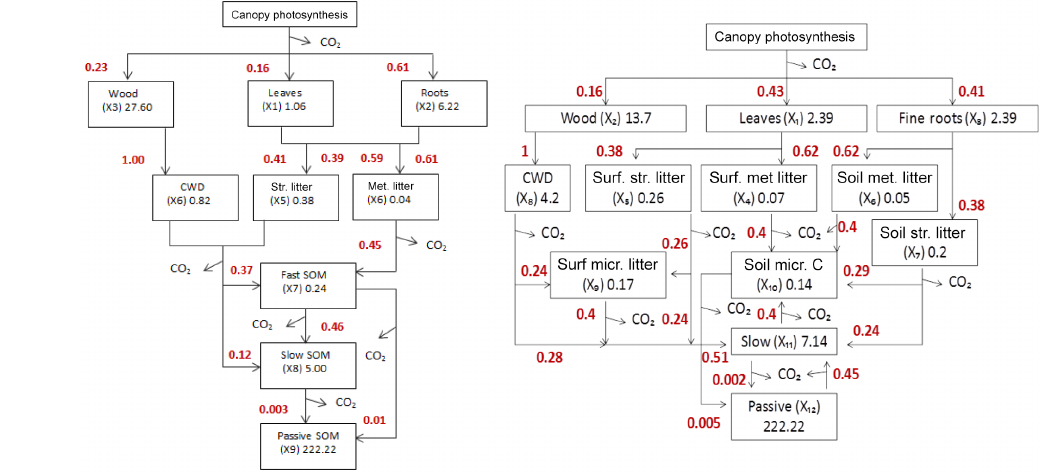
Figure 3. Schematic diagram showing the carbon cycle in CABLE (a) and CLM-CASA (cid:48) (b) . Carbon enters the system through photosyn- thesis and is partitioned among live pools. From live pools, carbon is transferred to litter pools, and from litter pools it is transferred to soil carbon pools. Values in boxes show the pools residence times. Values outside the boxes show the partitioning and transfer coefficients. The full names of the abbreviated carbon pools are coarse woody debris (CWD), structural litter (surface and soil), metabolic litter (surface and soil), surface microbial litter, soil microbial carbon, fast soil organic matter, slow, and passive soil organic matter.